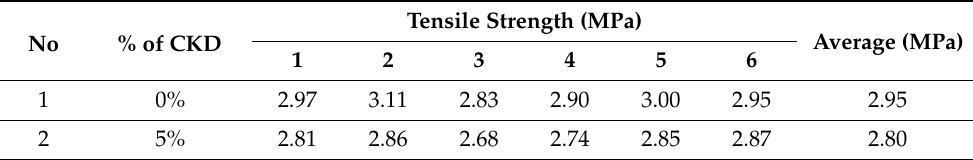
Table 4. Concrete tensile strength results.